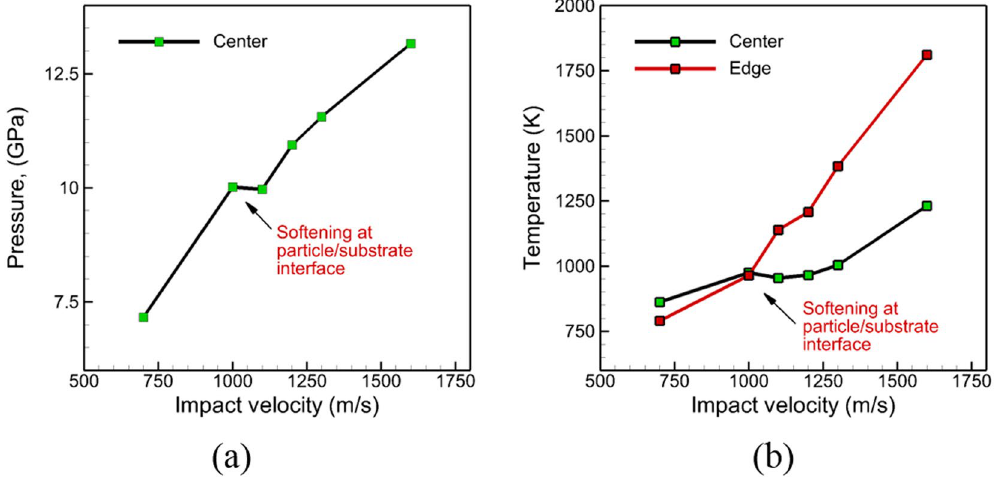
Figure 8. Plot of ( a ) peak pressure generated at the center of the particle/substrate interface at the location of impact, and ( b ) peak temperature generated at the center of the particle/substrate interface at the location of impact and at the periphery of the particle/substrate interface for different impact velocities considered